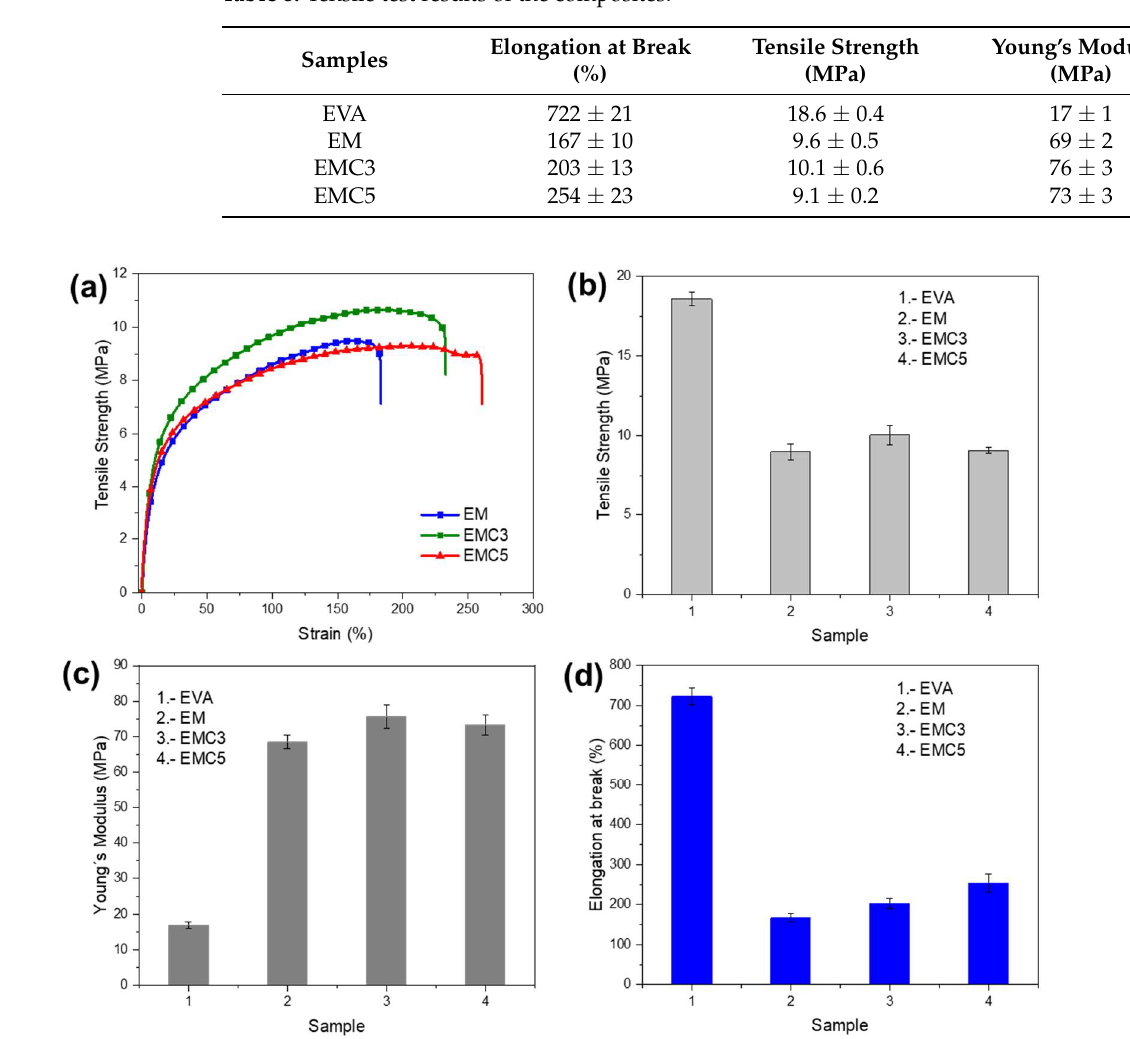
Figure 7. ( a ) Stress-strain curves of the pure EVA, EM, EMC3, and EMC5 composites, ( b ) Tensile strength, ( c ) Young’s Modulus and ( d ) Elongation at break (%) based on the stress strain curves.